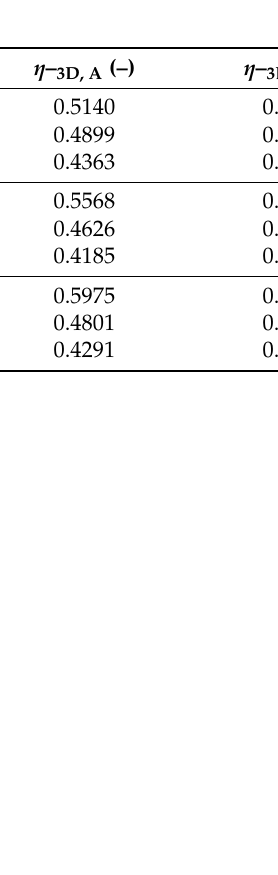
Table 4. Peak discharge.